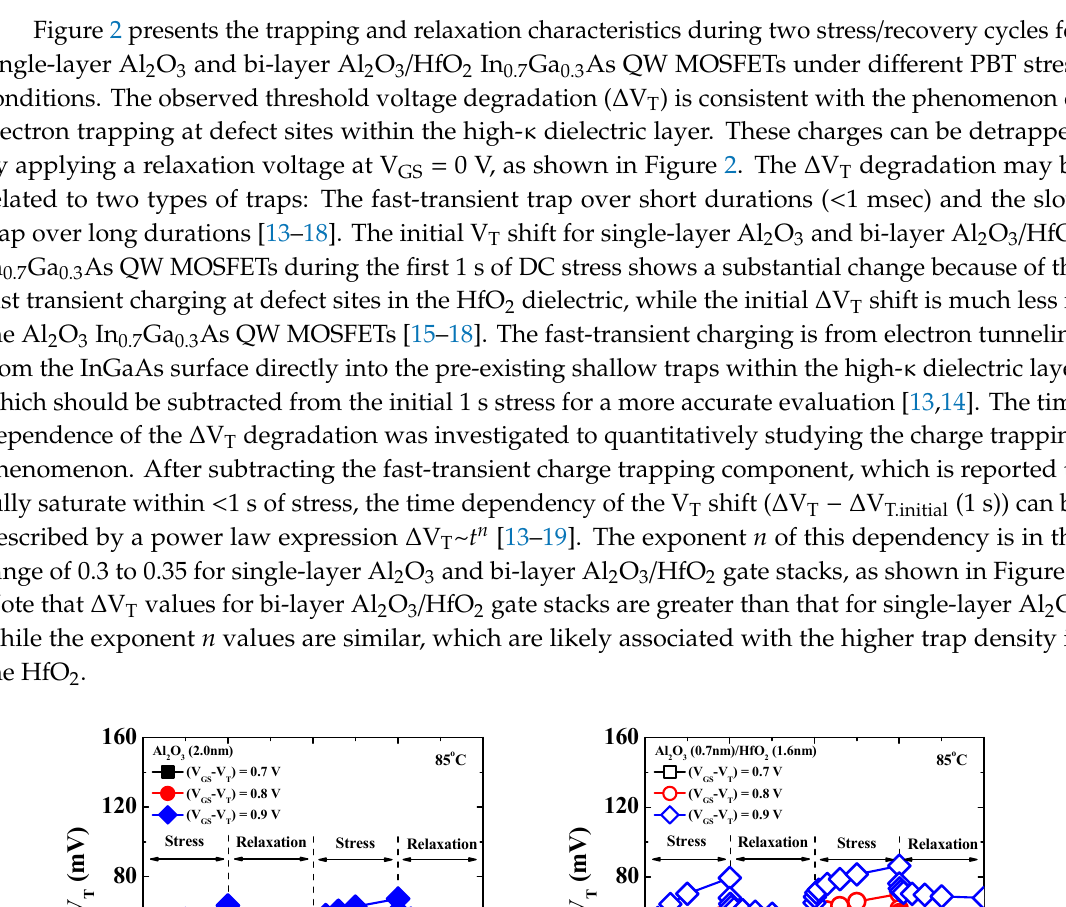
Figure 3. The power law time dependency of the observed threshold voltage degradation ( Δ V T ) excluding the fast-transient charge trapping components ( Δ V T – Δ V T.initial (1 s)) in single-layer Al 2 O 3 and bi-layer Al 2 O 3 /HfO 2 gate stacks under PBT stress conditions. The power law exponent n is 0.30–0.35. To further investigate the charge trapping characteristics, Δ V T was plotted as a function of the injected charge under different PBT stress conditions as shown in Figure 4a. The similar slopes of Q trapped /Q inj for single-layer Al 2 O 3 and bi-layer Al 2 O 3 /HfO 2 gate stacks (Figure 4b) indicate that these stacks exhibited similar charge trapping efficiencies [11,15,16,20–22]. The injected charges from the InGaAs channel are mostly trapped in defect sites within the high- κ dielectric. The long-term V T shift, Δ V T – Δ V T.initial (1 s), correlates well with the percentage of transconductance (%G m.Max ) degradation for single-layer Al 2 O 3 and bi-layer Al 2 O 3 /HfO 2 gate stacks, as shown in Figure 5. Generally, G m.Max degradation is related to the generation of interfacial state traps and Coulomb centers in the near- interface dielectric region [21,22]. However, G m.Max degradation increases as the amount of trapped electrons increases, as shown in Figure 5, which means that remote scattering is a sensitive factor in high- κ dielectric [11,15,16,20–22]. Therefore, the correlation seen between the G m.Max and Δ V T − Δ V T.initial (1 s) implies that significant charge trapping occurred in the border trap or/and defect sites within the high- κ dielectric, which is in the main high- κ dielectric layers for single-layer Al 2 O 3 and bi-layer Al 2 O 3 /HfO 2 gate stacks.